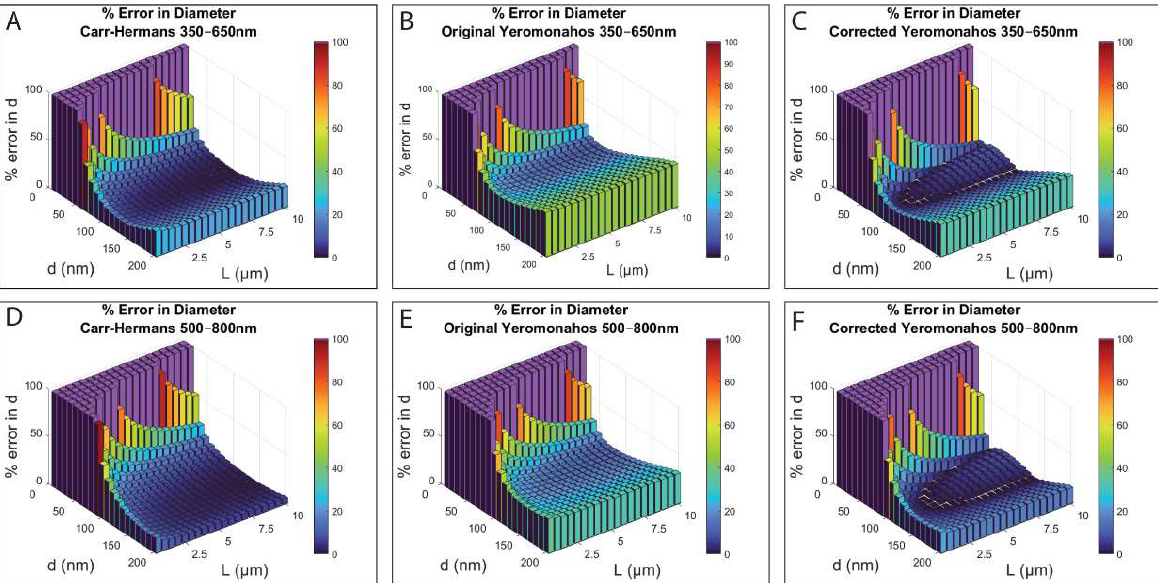
Figure 5. Percent error between the diameter obtained from fitting the three approaches to theoretical turbidity values created using full light scattering theory, and the value used to create the initial dataset for lengths of 0.5–10 μm and diameters of 10–200 nm for wavelength ranges of 350–650 nm ( A – C ) and 500–800 nm ( D – F ). (c = 0.0001 g/cm 3 , μ = 4.73 × 10 12 Da/cm, dn/dc and n corrected for wavelength dependence for fibers in HBS buffer; the purple bars represent imaginary diameter values calculated from the fit, and were assigned a value of 100% error for plotting purposes).